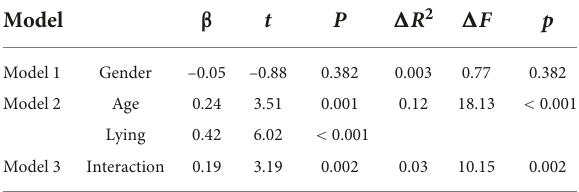
TABLE 1 Hierarchical regression analyses for predictors of children’s behavior